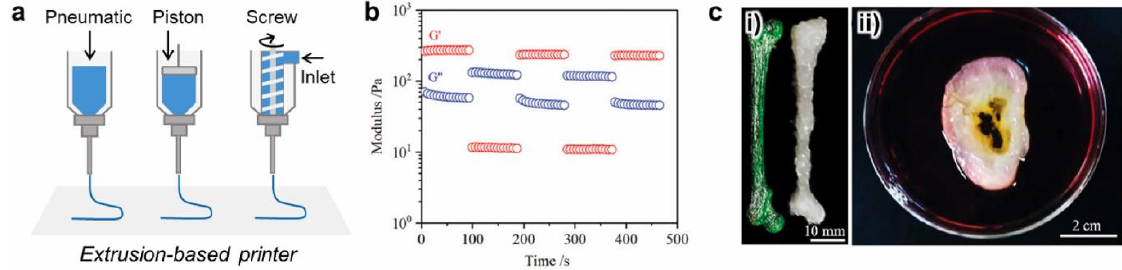
Figure 6. ( a ) Schematic of extrusion-based 3D printers. ( b ) Reversible gel-sol transition of particular gel-based ink under cyclic shearing strains of 1% (G′ > G″) and 10% (G′ < G″). ( c ) i. A rat-size thigh-bone and ii. a human-size ear model fabricated by extrusion-based 3D printing. Reprinted with permission from Elsevier [152].